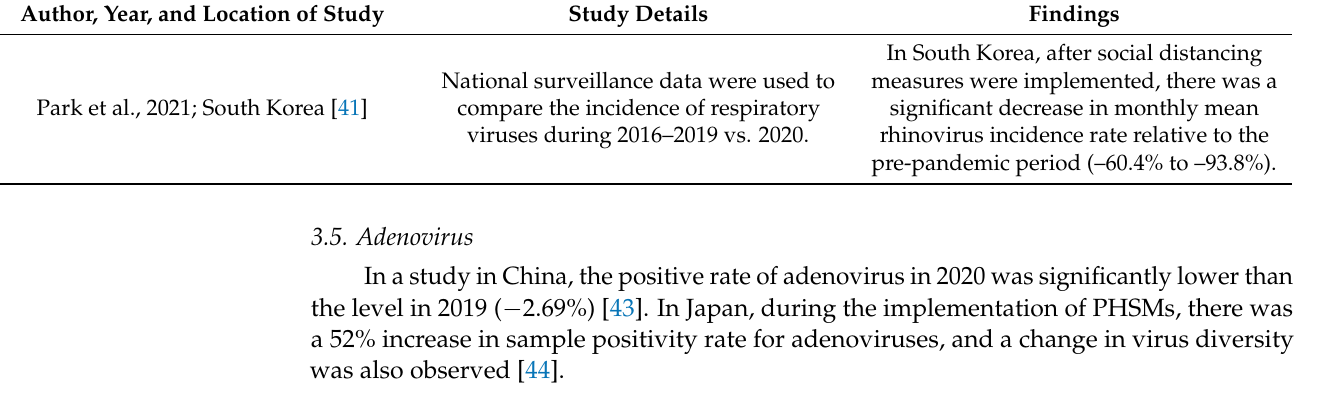
Table 5. Summary of adenovirus-related articles included in the systematic literature